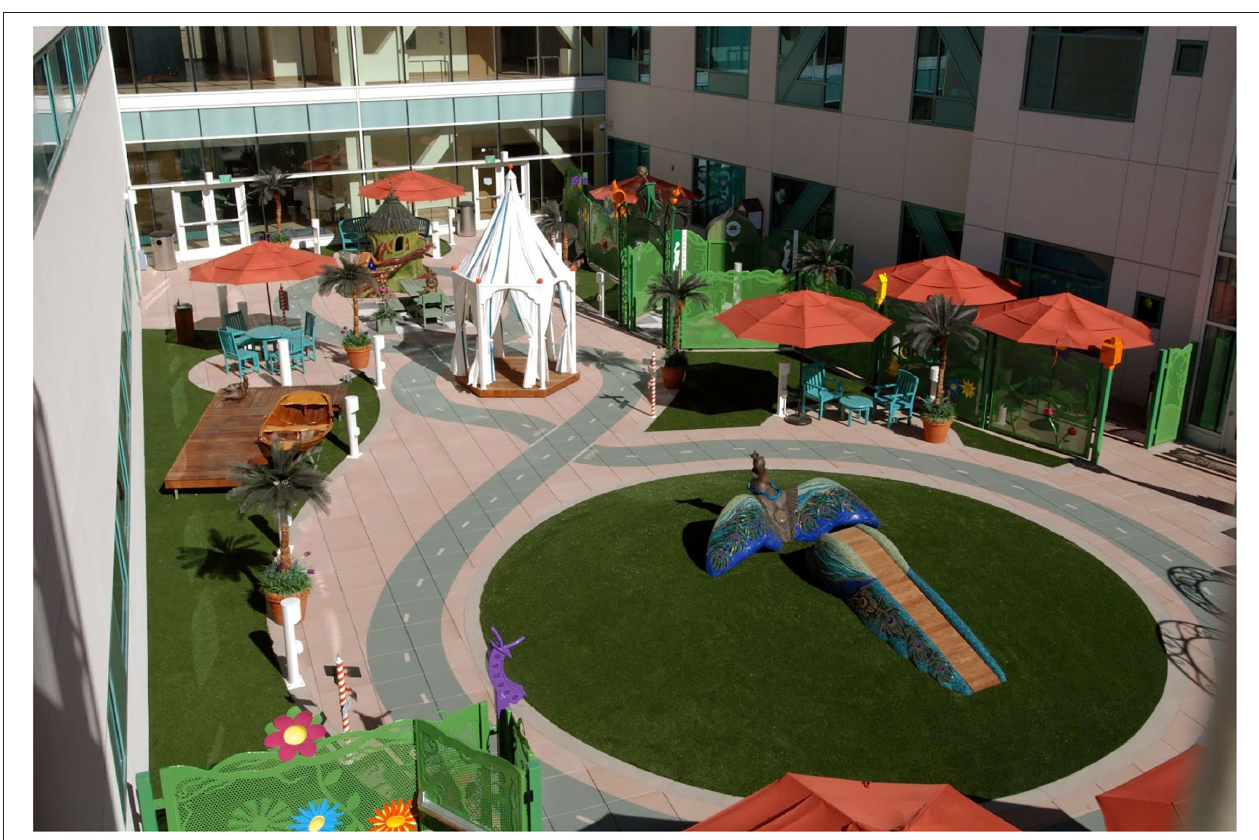
FIGURE 4 | A patient’s view of Carley’s Magical gardens located at Rady Children’s Hospital, San Diego, California (photograph used with permission, Nelson, 2004).